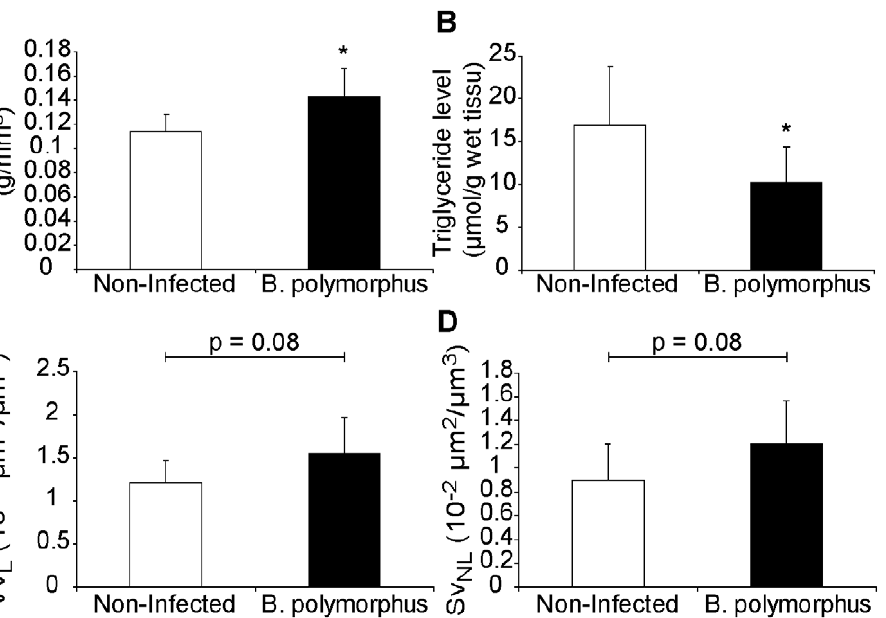
Figure 4. Effects of the trematode Bucephaluspolymorphus on four physiological parameters of the zebra mussel (mean values ± S.D.). (A) Condition index, (B) Level of triglycerides in the gonads, (C) the structural changes of the lysosomale (volume density), and (D) the neutral lipid content in the digestive gland (surface density). Significant differences were indicated by an asterisk (t-test, p , 0.05).